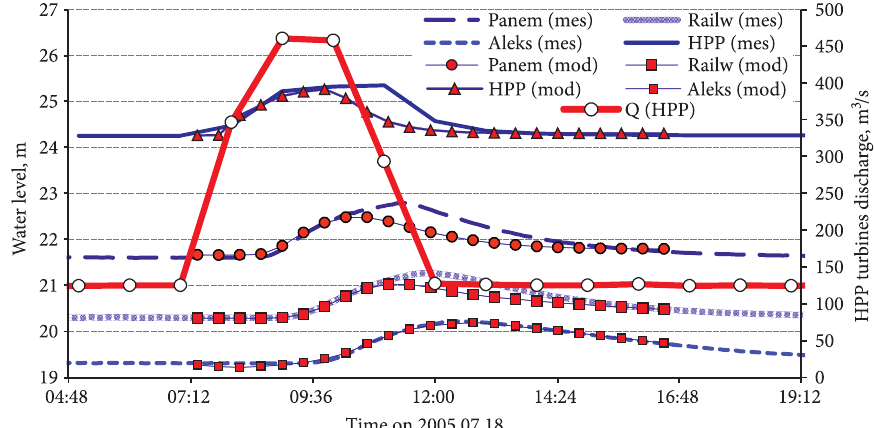
Fig. 7. Comparison of actual measurements of Kaunas HPP impact on the Nemunas river water levels and results obtained from the 1 st stage of the model